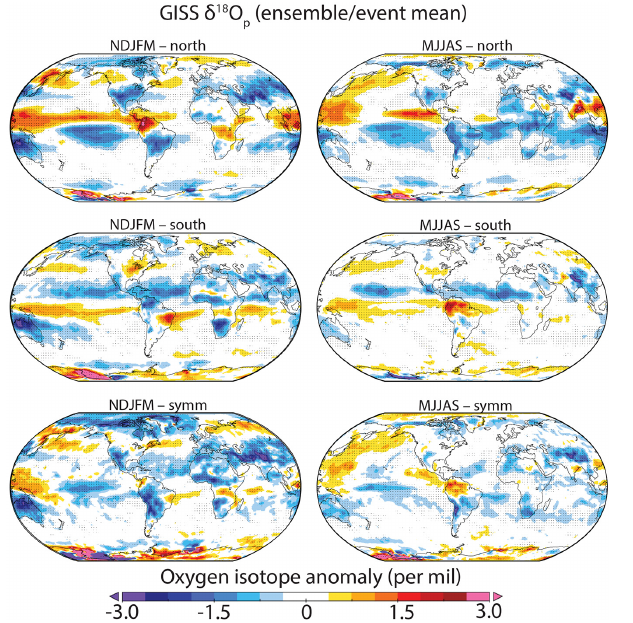
Figure 7. GISS-E2 spatial composite of the oxygen isotope anomaly (‰) in (top row) ASYMM NH , (middle row) ASYMM SH , and (bottom row) SYMM events in (left column) NDJFM and (right column)